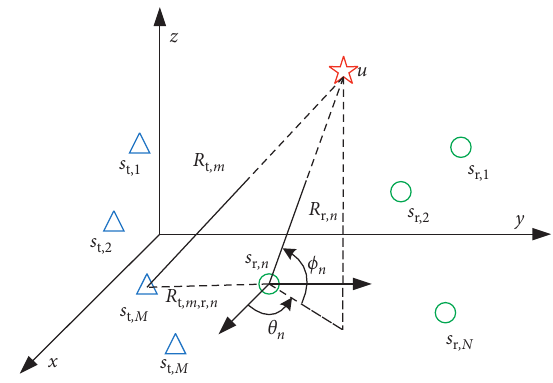
Figure 1: A typical localization scenario with distributed MIMO